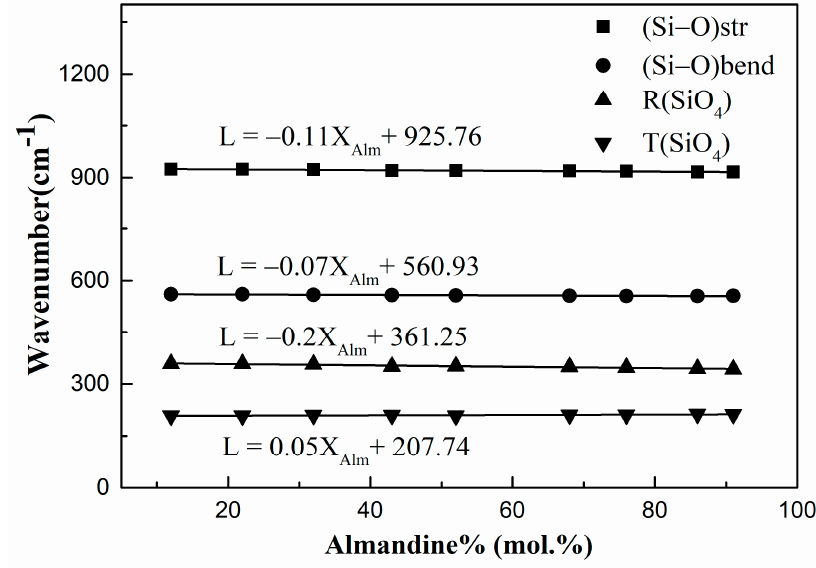
Figure 11. Selected Raman mode frequencies change with composition along Alm-Pyr binary. The solid lines are the linear fit results.